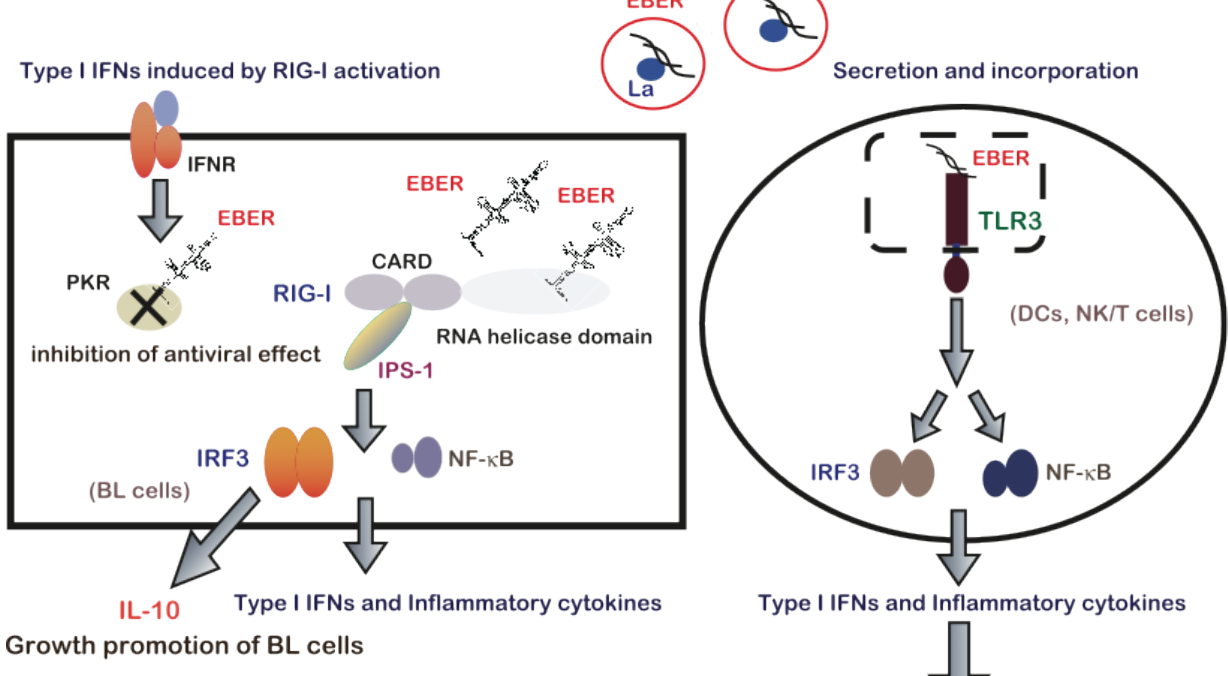
Figure 2. EBER-mediated modulation of innate immune signaling contributes to EBV-mediated pathogenesis. Reproduced from Iwakiri et al. [71]. Left, in BL cells, EBERs are recognized by RIG-I via the RNA helicase domain of RIG-I and following recognition, RIG-I associates with the adaptor IPS-1 via its CARD. IPS-1 initiates signaling leading to the activation of IRF3 and NF-κB to induce type I IFNs and inflammatory cytokine expression. EBERs induce the expression of the growth-promoting cytokine IL-10 via RIG-I-mediated IRF3 activation and might support BL development. EBERs also bind to IFN-inducible PKR and block its activity, which is required for the IFN-mediated antiviral effect; therefore, EBV might maintain a latent infection state. Right, activation of innate immunity via TLR3 signaling in response to secreted EBER. During an active EBV-infection, EBER1 is released from EBV-infected lymphocytes primarily in a complex with La. Circulating EBER induces DC maturation via TLR3 signaling and induces type I IFN and inflammatory cytokine production by activating IRF3 and NF-κB. DC activation leads to T cell activation and systemic cytokine release. Furthermore, TLR3-expressing T and NK cells including EBV-infected T or NK cells could be activated by EBER1 through TLR3, thus leading to inflammatory cytokine production. Therefore, immunopathologic diseases caused by active EBV infections including T or NK cell activaiton and hypercytokinemia, could be attributed to EBER1-induced TLR3-mediated T cell activation and cytokinemia. EBER, Epstein-Barr virus encoded RNA; EBV, Epstein-Barr virus; BL, Burkitt’s lymphoma; IPS-1, interferon-β promoter stimulator-1; CARD, caspase recruitment domain; RIG-I, retinoic acid-inducible gene I; DC, dendritic cell; IFN, interferon; NK cell, natural killer cell; IL, interleukin; TLR, Toll-like receptor; PKR, RNA-dependent protein kinase; IRF 3, interferon regulatory factor